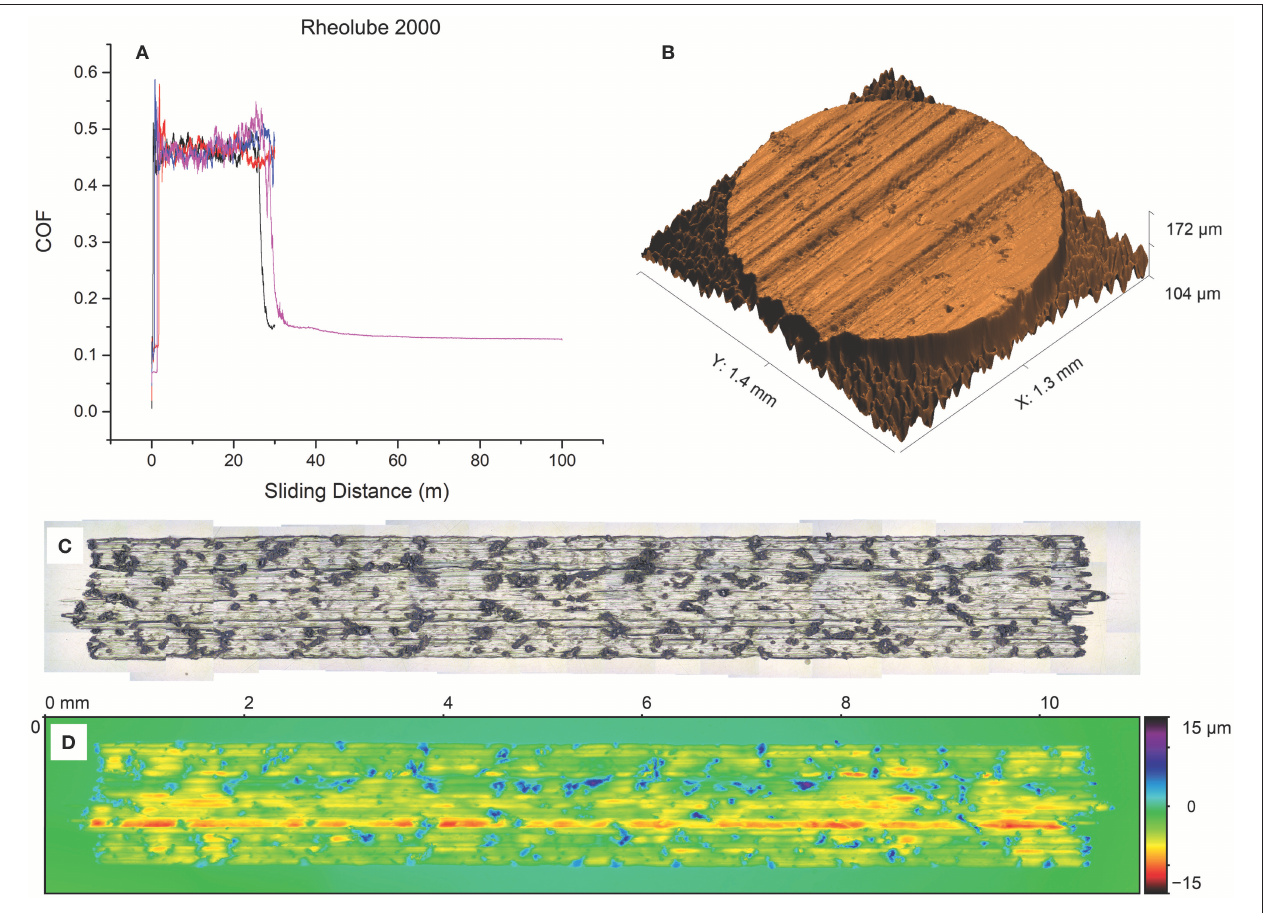
FIGURE 6 | Test results for Rheolube 2000 including (A) friction traces, (B) interferometer image of the ball wear scar, and (C,D) optical microscope and interferometer images of the flat wear scar. All wear images correspond to the test shown in black in (A)